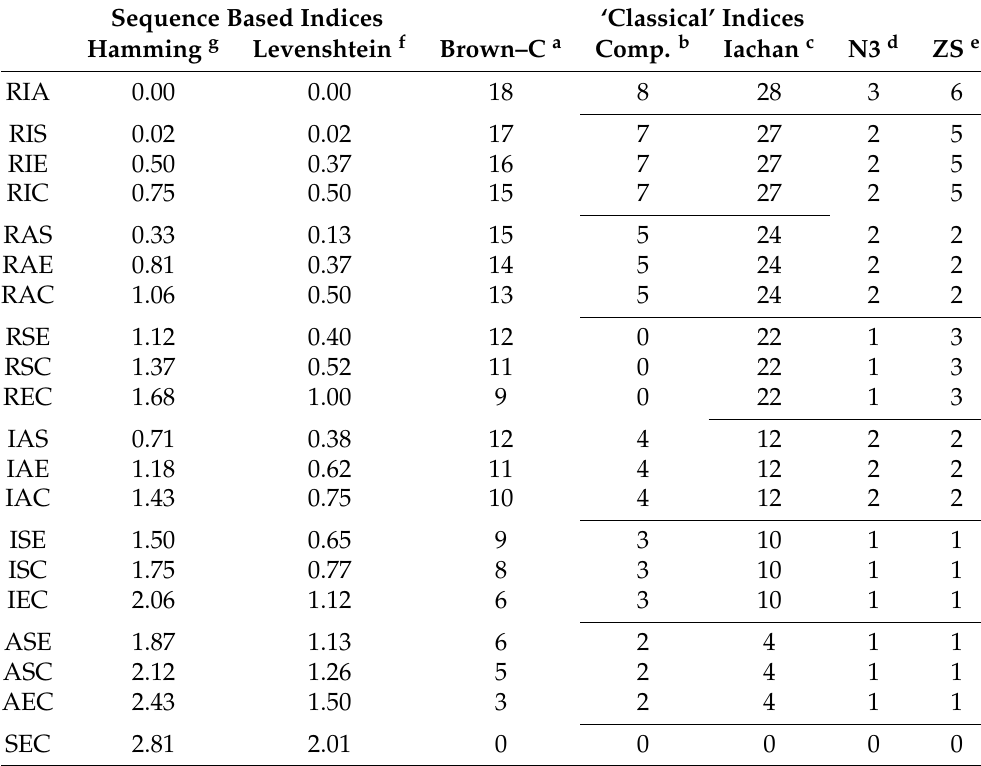
Table 2. Values for congruence between the single “ RIA ” environment code and some possible combinations of personal three-letter codes for seven